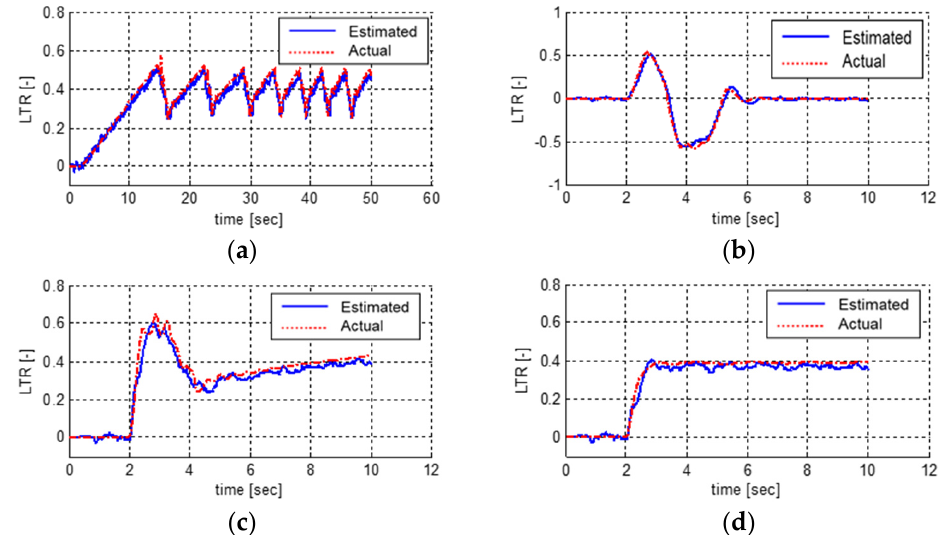
Figure 5. Estimated LTR using lateral acceleration and actual LTR : ( a ) Slowly increasing steering maneuver; ( b ) Sine with Dwell test; ( c ) 120 deg step steer; ( d ) 60 deg step steer.